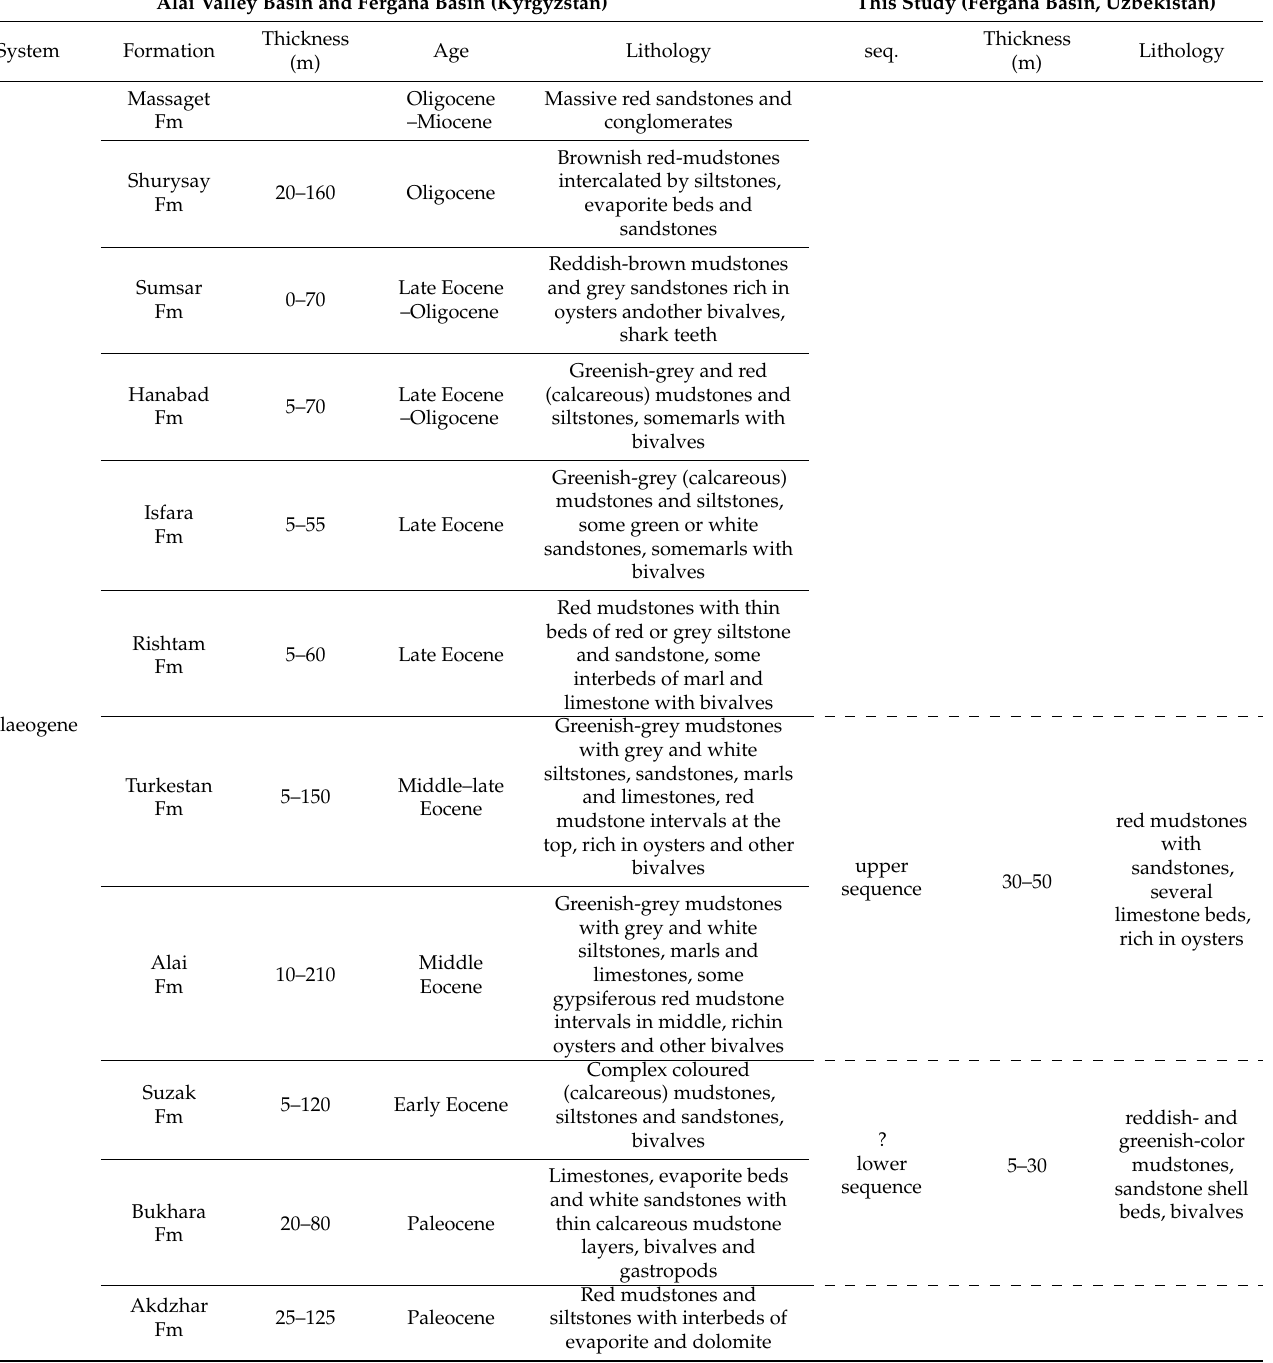
Table 2. Simplified lithostratigraphy and geological correlations of the studied section. The stratig- raphy and lithology of the Alai Valley Basin and the Fergana Basin (Kyrgyzstan) were obtained from